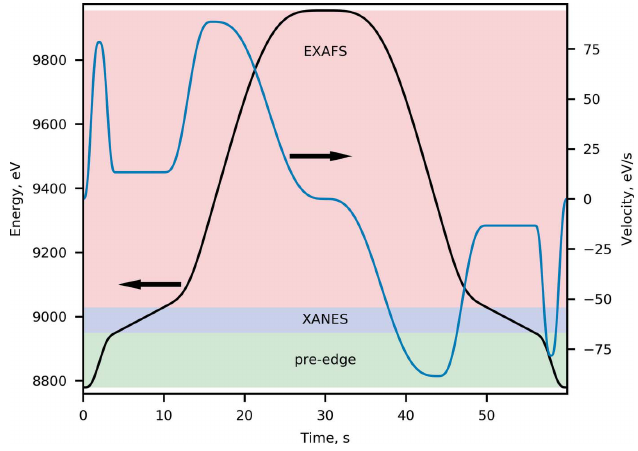
Figure 3 Example of a motion trajectory designed at ISS for the Cu K -edge at 8979 eV. Energy and velocity profiles are shown in black and blue,